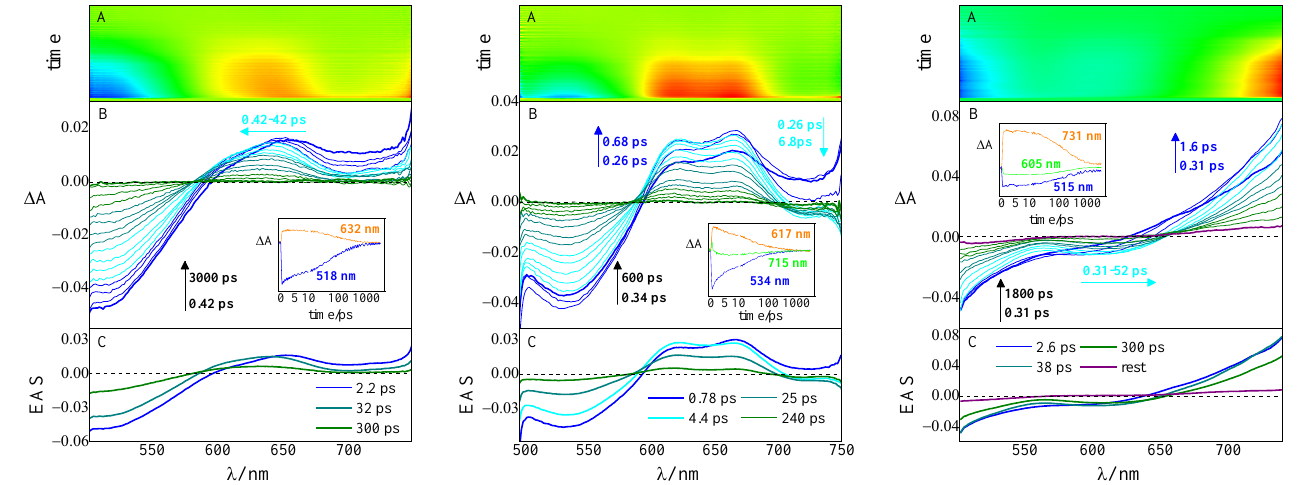
Figure 4. Pump – probe absorption spectroscopy of compound 3 ( left graph), 4 ( central graph), and 5 ( right graph) in ETN buffer solution, pH 7.4, complexed with tRNA, r ([compound]/[tRNA]) = 0.005 ( λ exc = 400 nm): ( A ) contour plot of the experimental data, ( B ) time-resolved absorption spectra recorded at different delays after the laser pulse (inset: decay kinetics recorded at meaningful wavelengths), and ( C ) Evolution Associated Spectra (EAS) obtained by global analysis.